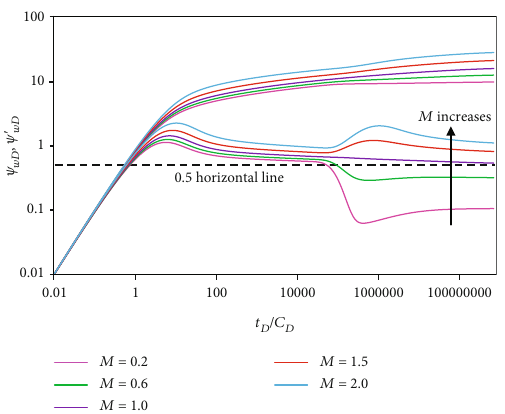
Figure 17: Well test curves of the pressure buildup well test under di ff erent mobility ratios.